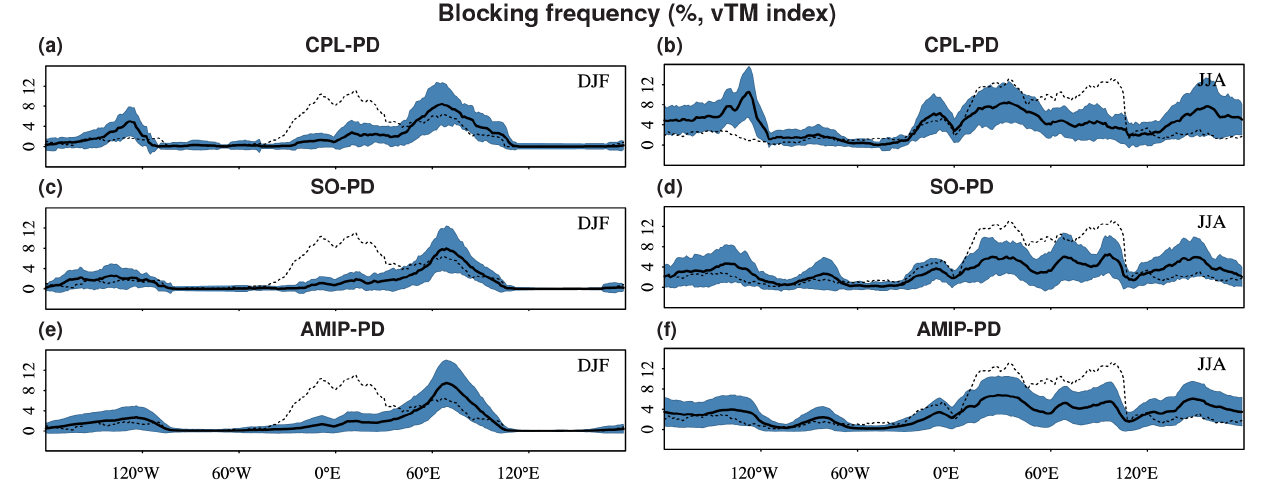
Figure 17. PD climatology of blocking frequency from NorESM1-Happi (a, b) , NorESM1-HappiSO (c, d) , and NorESM1-HappiAMIP (e, f) for DJF (a, c, e) and JJA (b, d, f) . Shown are the mean (solid black line) and the spread (blue shading; ± 1SD) computed over the number of available decades (nine for NorESM1-Happi and NorESM1-HappiSO, and 125 for NorESM1-HappiAMIP) for the default time periods given in Sect. 3. Blocking frequency from ERA-Interim is shown for the period 1986–2015 (dotted black line). The blocking events are identified using the Tibaldi and Molteni (1990) blocking index with variable central latitude (vTM) (Tibaldi and Molteni, 1990; Pelly and Hoskins, 2003), as in Iversen et al. (2013). It is based on the TM index (Tibaldi and Molteni, 1990), which uses a persistent reversal of the meridional gradient of the 500hPa geopotential height around the predefined central blocking latitude at 50 ◦ N as an indicator for blocking. The reversal must be present at 7.5 ◦ consecutive longitudes and persist for at least 5d. In the vTM index, the requirement of a predefined central blocking latitude is relaxed in order to reduce spurious detection (Pelly and Hoskins, 2003). The central latitude is allowed to vary with longitude following the latitude of the maximum in the climatological storm track (using bandpass-filtered geopotential height at 500hPa). To account for the seasonal cycle of the cyclone activity, the central latitude for a given month is calculated as the climatological 3-month moving average centred on that month. Units are percentages (a–f)